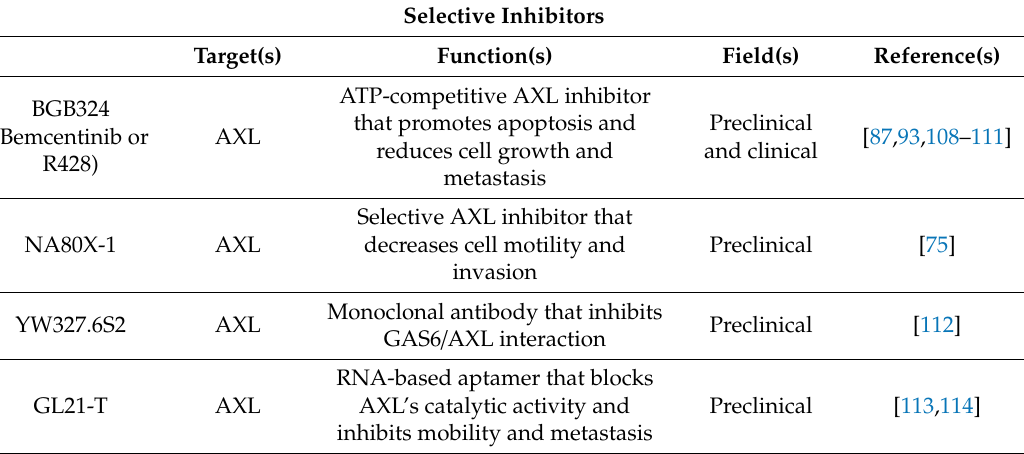
Table 2. AXL inhibitors. Several AXL inhibitors (selective or not) are involved in the treatment of breast cancer. Many of them, however, are still in preclinical